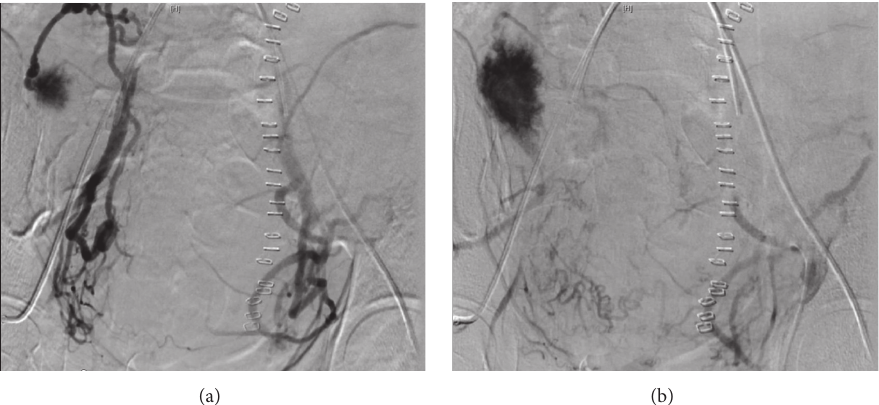
Figure 2: Fluoroscopy images prior to embolization of the branches of the internal iliac arteries demonstrating increased vascularity on the right branches compared to the left branches. The dark spot in (b), taken immediately following (a), indicates placental parenchyma.